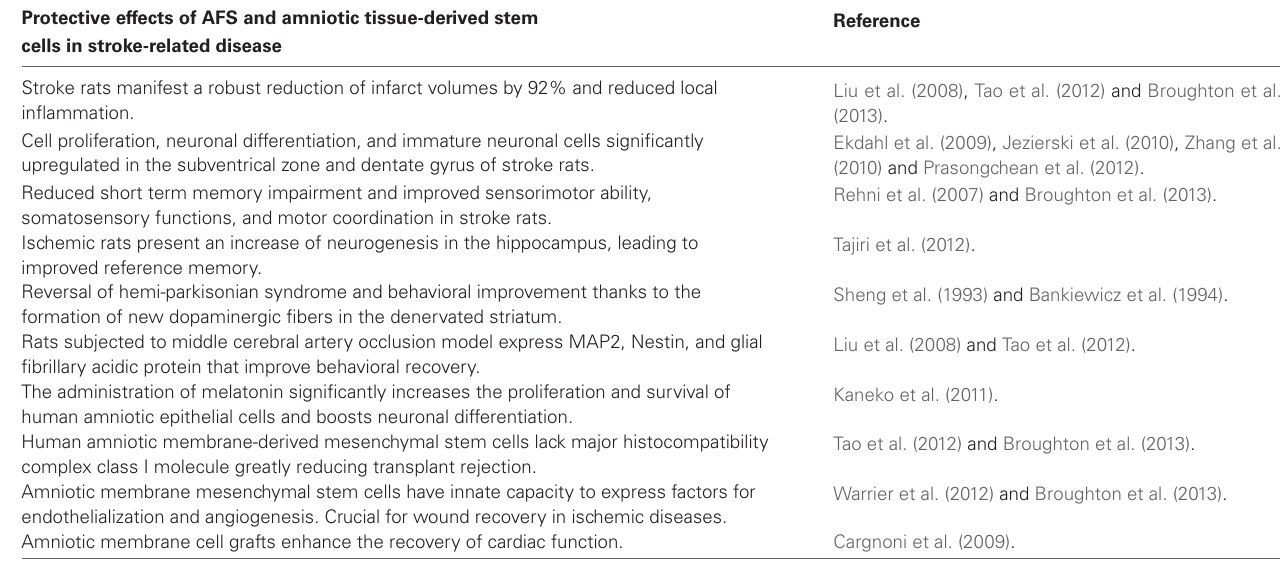
Table 1 | Effects of AFS cells and amniotic tissue-derived cell in stroke-related disease . Protective effects of AFS and amniotic tissue-derived stem Reference cells in stroke-related disease Stroke rats manifest a robust reduction of infarct volumes by 92% and reduced local